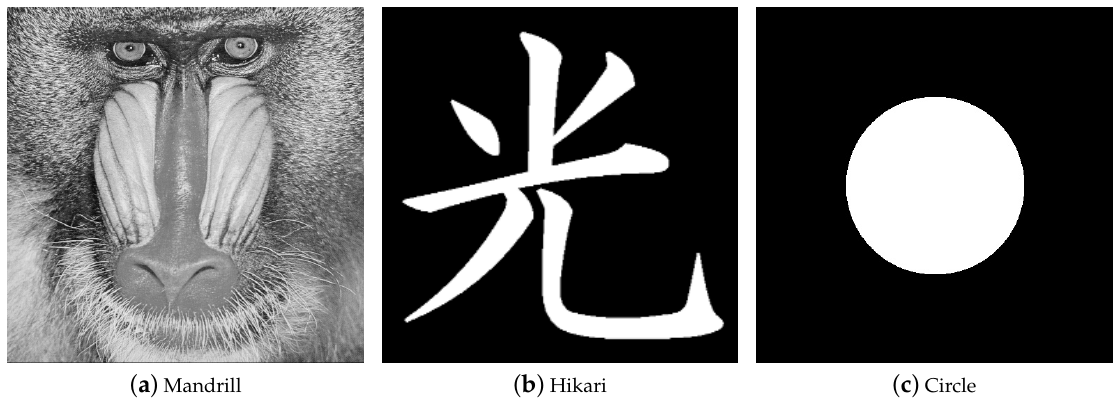
Figure 3. Target images: ( a ) mandrill (resolution 512 × 512), ( b ) hikari (resolution 256 × 256), and ( c ) circle (resolution 512 × 512).